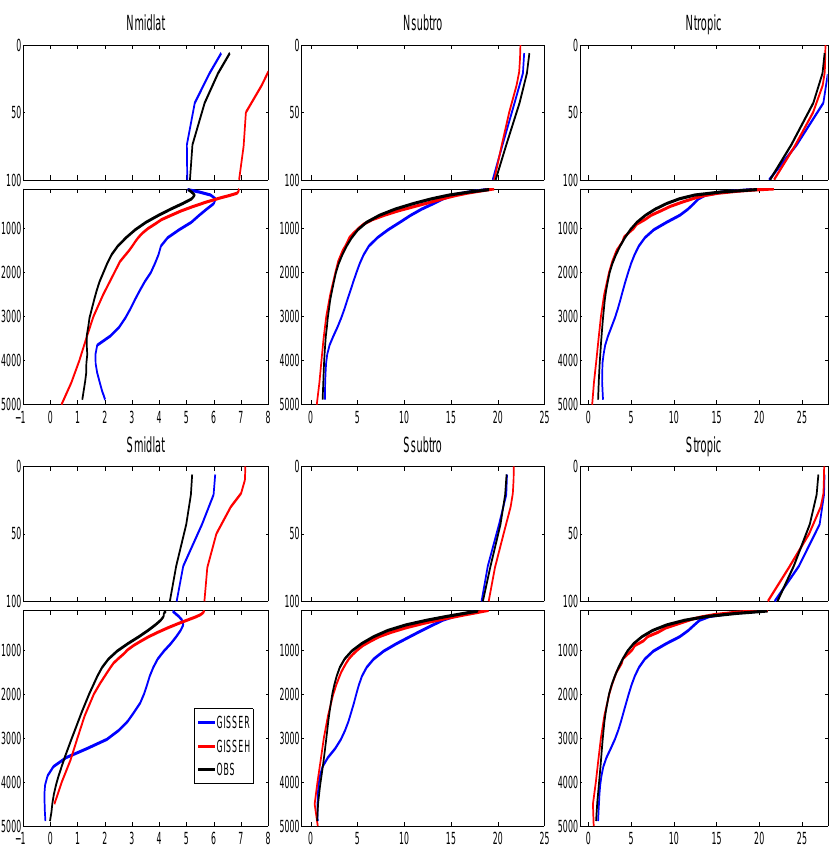
Fig. 2. Potential temperature profiles from the two models and observations in the same regions as in Fig. 1. Vertical axis is stretched near the surface and the units are in meters. (a) R: diff (Rhi−Rlo) ndet at the surface